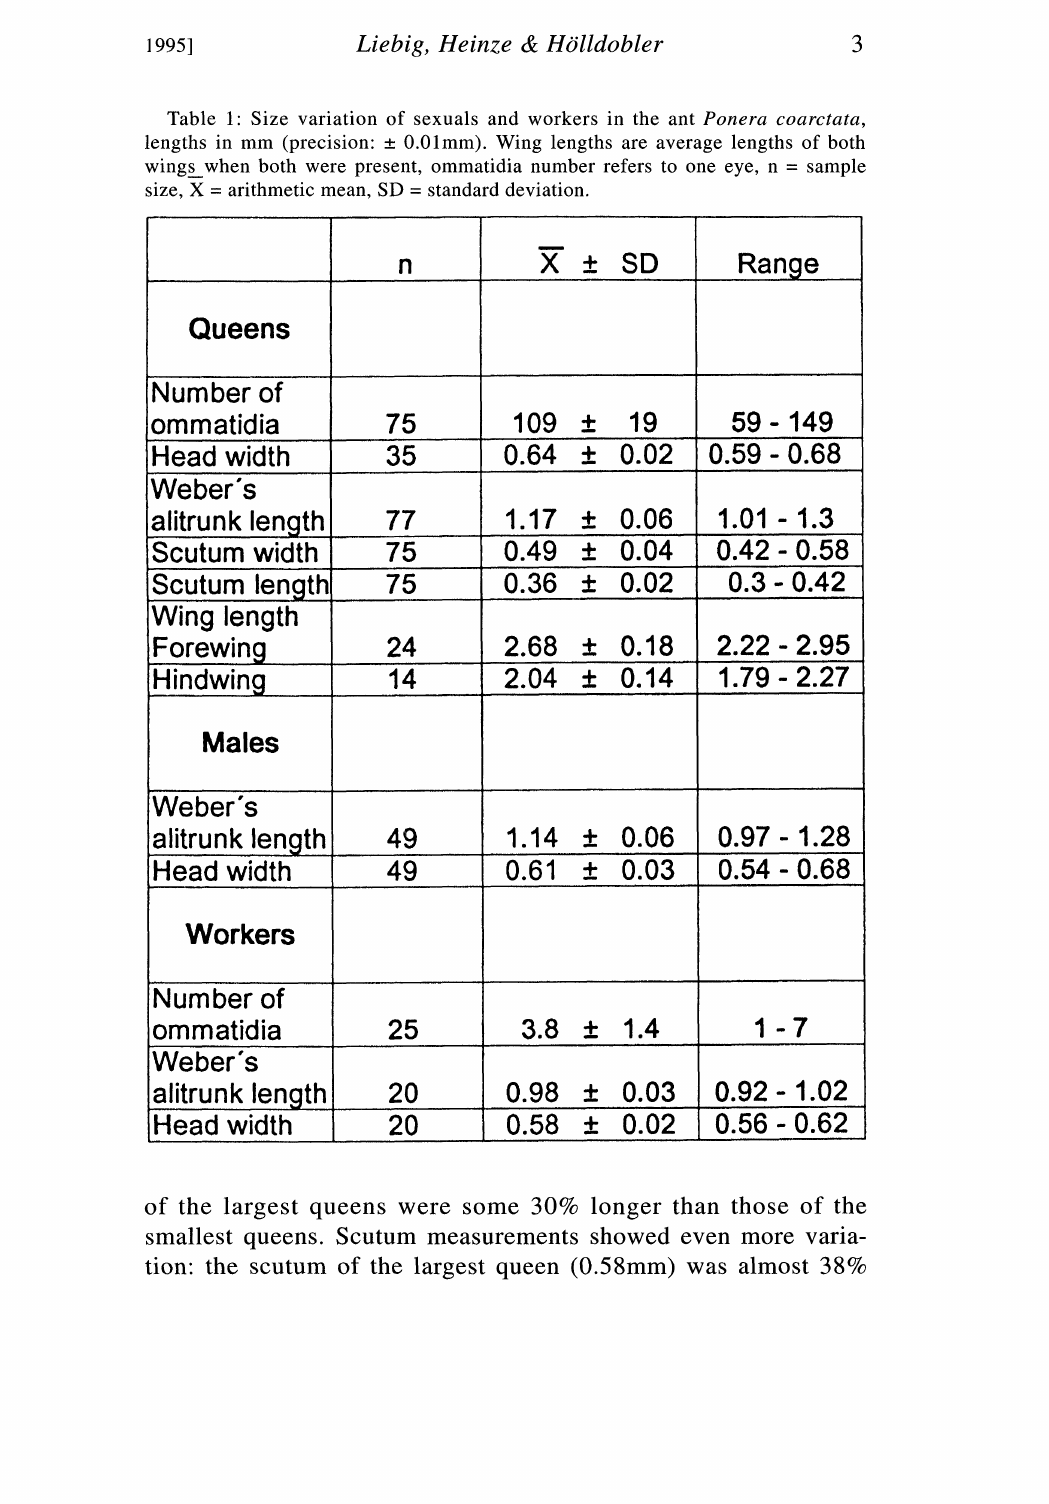
Table 1: Size variation of sexuals and workers in the ant Ponera coarctata, lengths in mm (precision: _+ 0.01mm). Wing lengths are average lengths of both wingswhen both were present, ommatidia number refers to one eye, n sample size, X arithmetic mean, SD standard